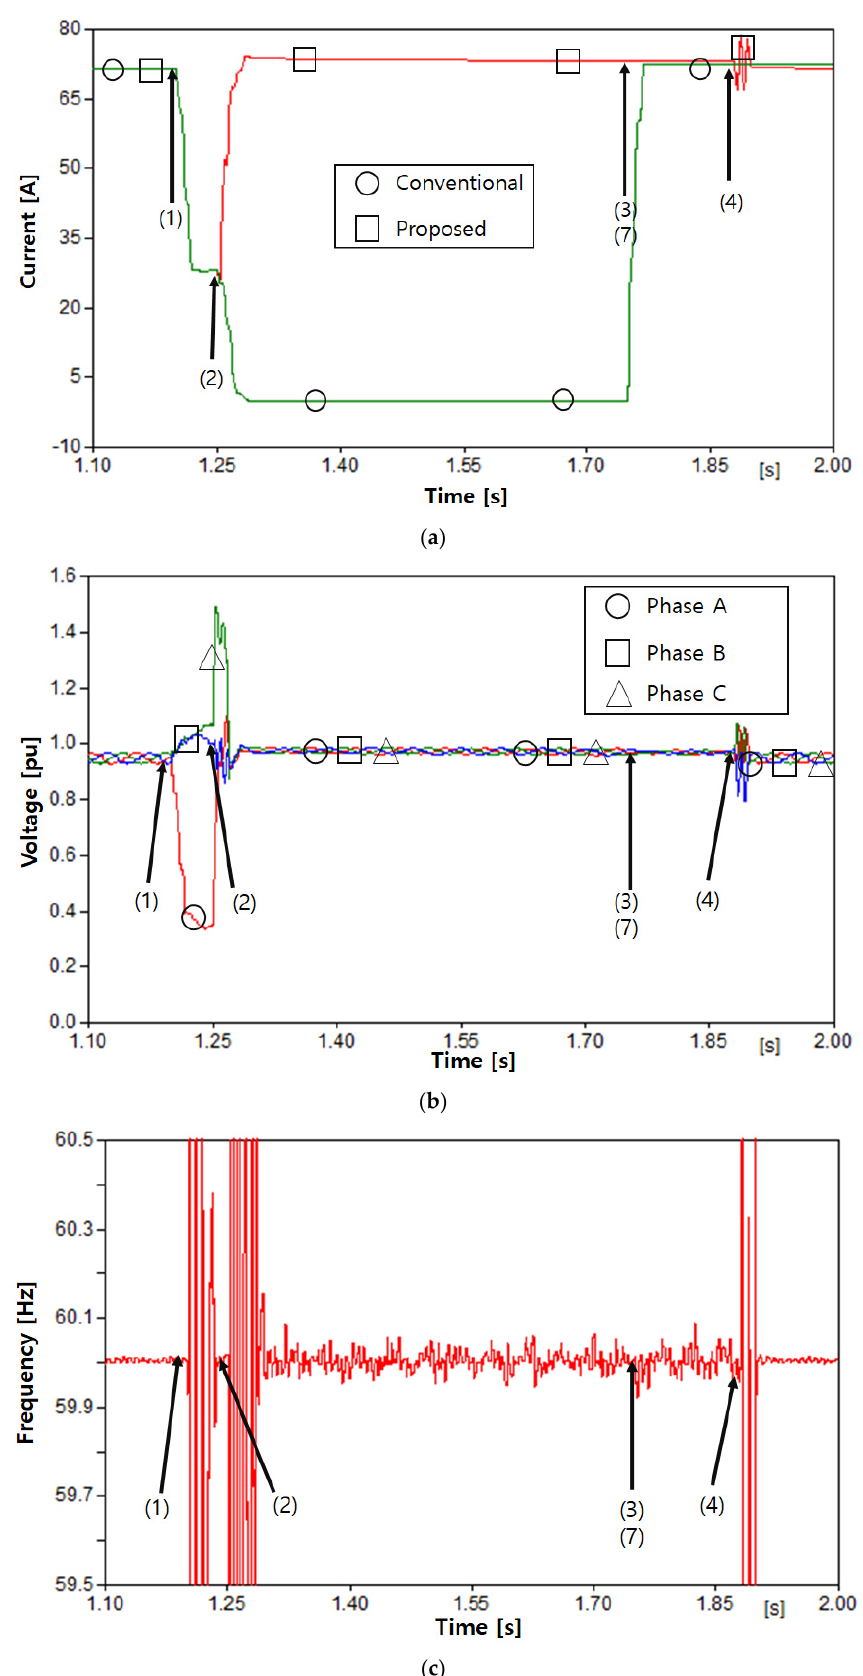
Figure 9. Simulation results of Case 2: ( a ) current flowing to Load 2; ( b ) voltage at Bus 3; ( c ) frequency at Bus 3.